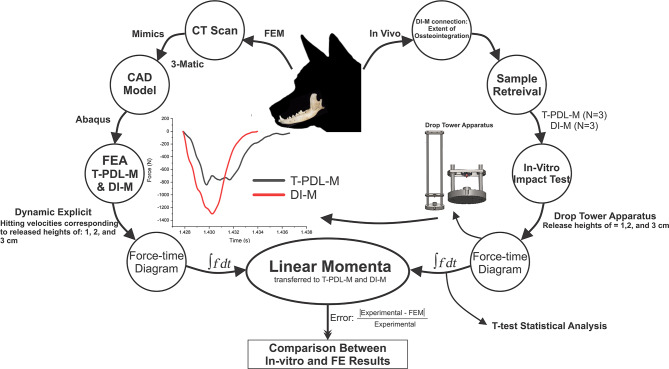
Schematic block diagram of the experimental set-up and FEA procedure.